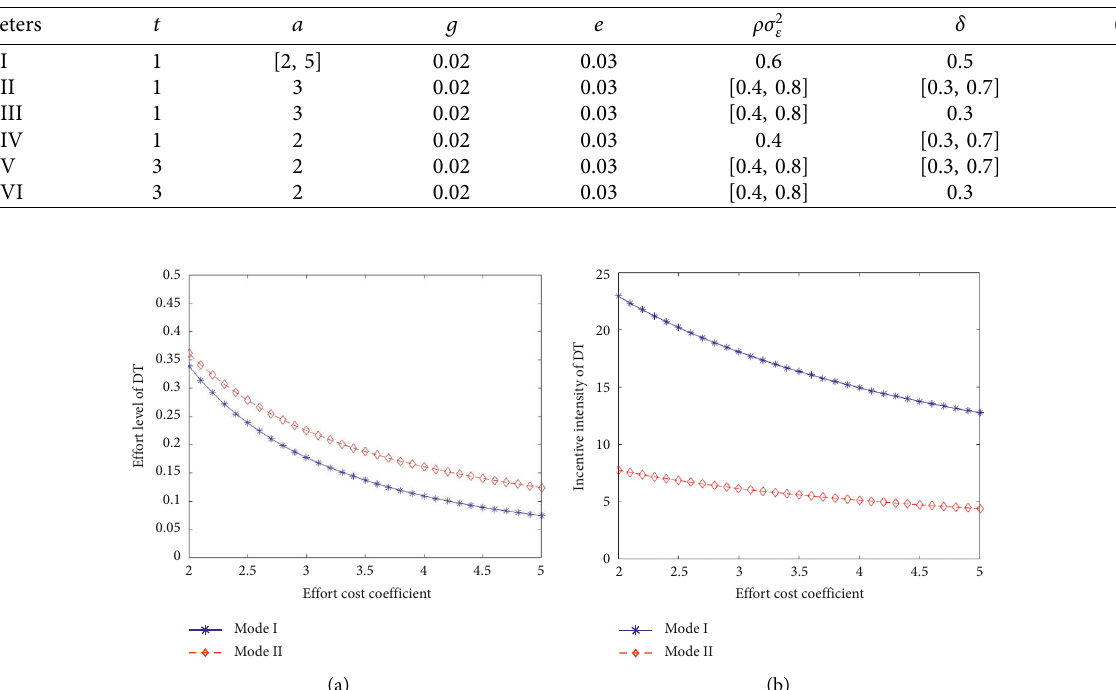
Figure 1: Comparative results of model I and model II. (a) The effort level of DT. (b) Incentive intensity of DT.